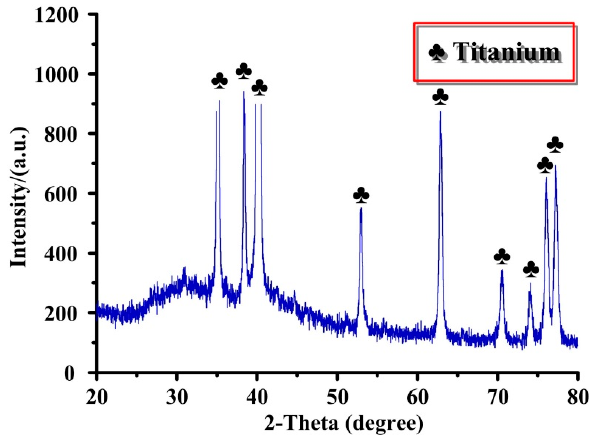
Figure 3. XRD spectrum of MN-Ti.